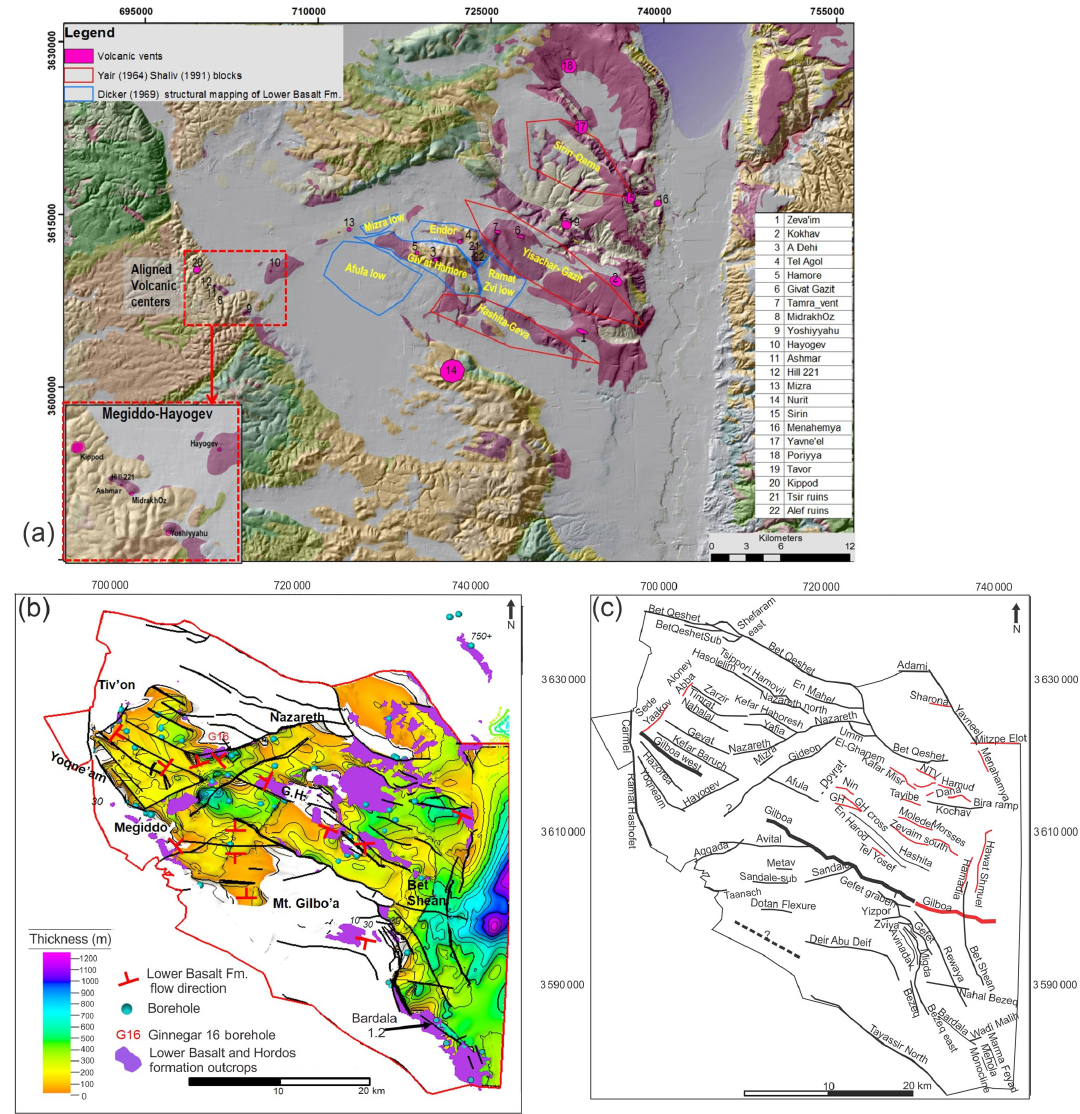
Figure 10. (a) Inferred volcanic sources for the Lower Basalt Formation. Miocene edifices interpreted by Yair (1968), Dicker (1969), and Shaliv (1991) are ascribed to normal faulting synchronous with Lower Basalt Formation flows. Part of the sources was interpreted using potential methods (Segev and Rybakov, 2011). (b) Isopach map of the inter-fingering Lower Basalt Formation and the Hordos Formation. Locally, the latter predates the former. Contour spacing: 100m. G.H. – Givat Hamore (c) Faults within the study area. Red lines: post-Avedat Group (lower to middle Eocene) faults. Black fault lines: offset all surfaces within the scope of this study from top of Judea Group to top of Lower Basalt Formation (upper Cretaceous to